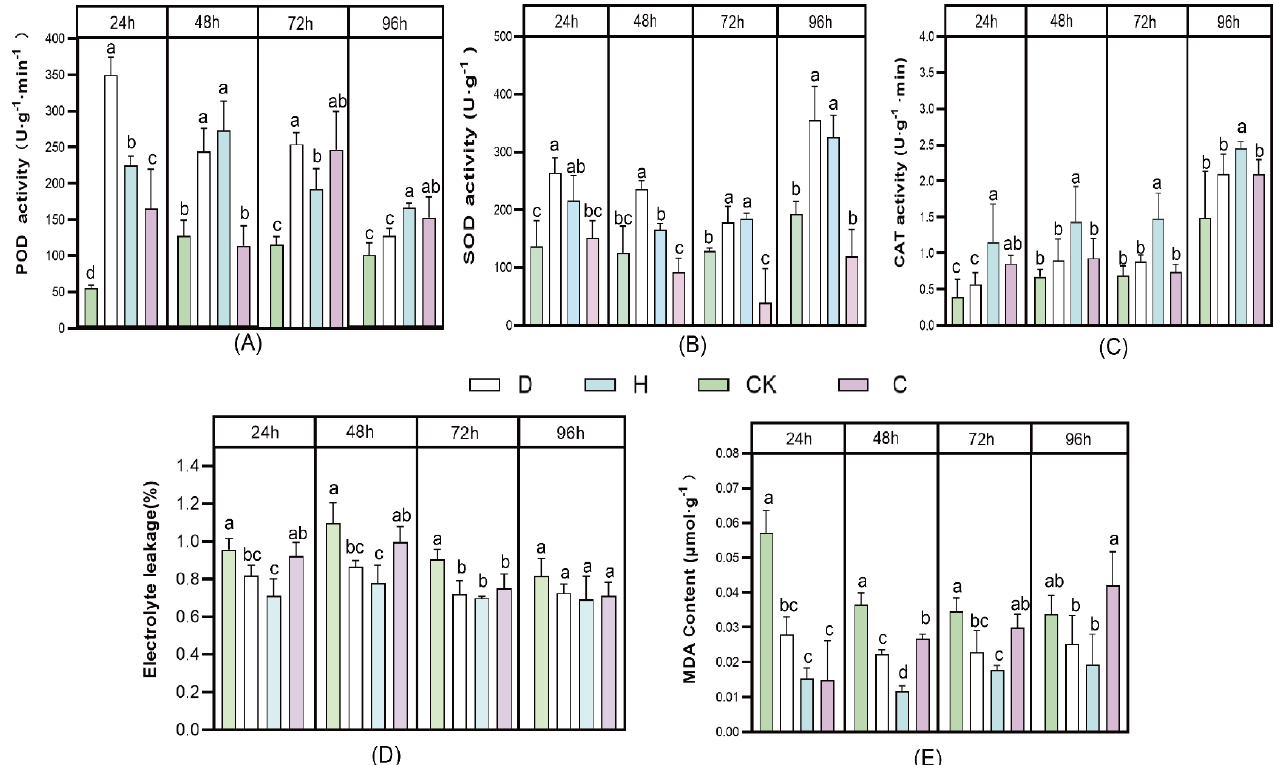
Figure 2. Effects of different treatments on the antioxidant capacity of Faba bean leaves with Fusarium wilt. ( A ) POD activity, ( B ) SOD activity, ( C ) CAT activity, ( D ) electrolyte leakage, and ( E ) MDA content. Values are means ± SDs ( n = 3). Bars marked with different letters (a, b, c) represent significant differences ( p < 0.05). The Fusarium wilt of Faba bean was inoculated with H (10 μ g/mL), D (1 μ g/mL), 10 g/L carbendazim (C), and seedlings treated with sterile water served as controls (CK).